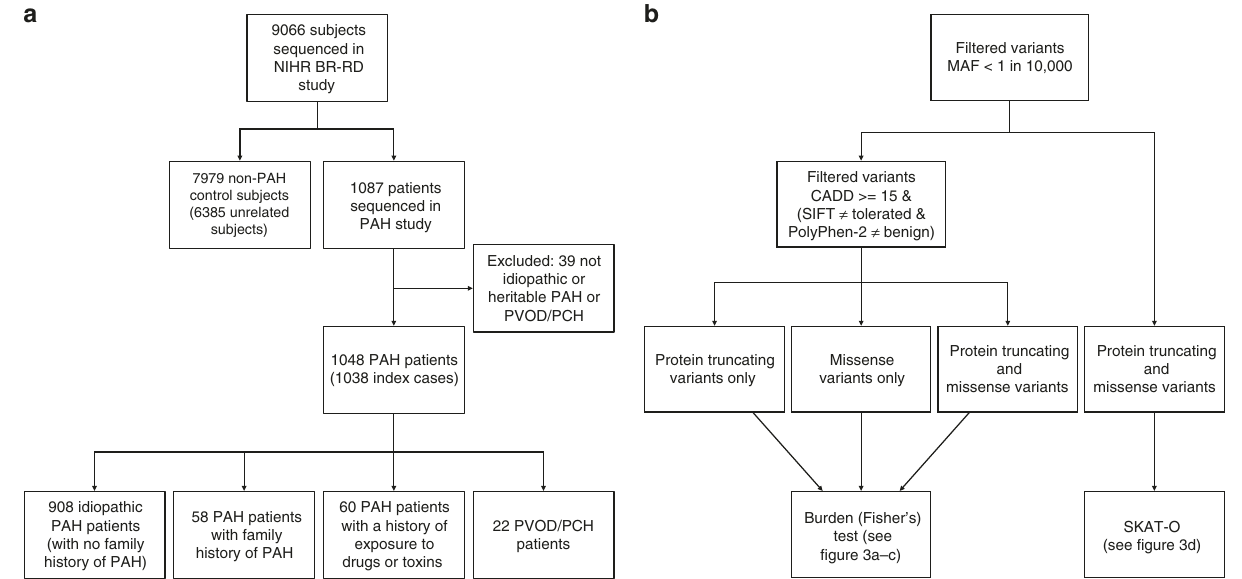
Fig. 1 Flow diagrams illustrating a the composition of the NIHR BioResource — Rare Diseases (NIHR BR-RD) PAH study and b the analysis strategy to identify novel PAH disease genes. a The study comprised 1048 adult cases (aged 16 or over) attending specialist pulmonary hypertension centres from the UK ( n = 731), and additional cases from France ( n = 142), The Netherlands ( n = 45), Germany ( n = 82) and Italy ( n = 48). b A series of case-control comparisons including and excluding cases with variants in previously reported disease genes were undertaken using complementary fi ltering